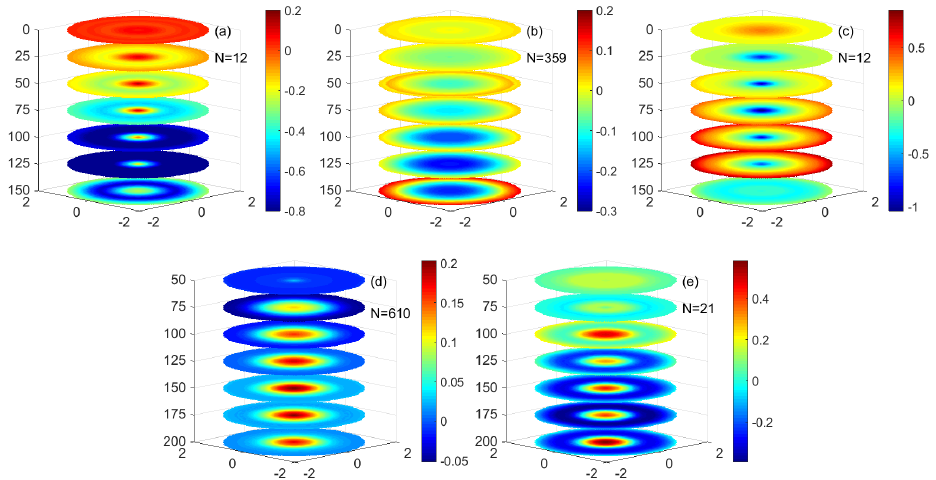
Figure 14. The three−dimensional monopole structure of ageostrophic vertical velocity and anoma- lies of the different eddies. ( a − e ) are ( a ) mode−water eddies, ( b ) low nonlinear anticyclonic eddies, ( c ) high nonlinear anticyclonic eddies, ( d ) low nonlinear cyclonic eddies, and ( e ) high nonlinear cyclonic eddies. (Unit: